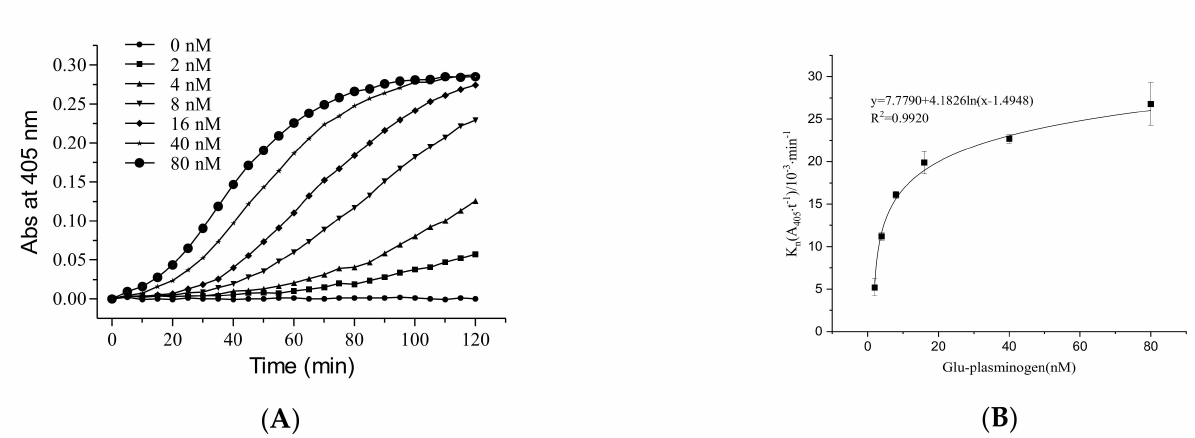
Figure 2. The role of Glu-plasminogen in the fibrinolytic activity of FGFC1. Plot of A 405 versus time ( A ) and the values of K n ( B ) at different Glu-plasminogen concentrations (0–80 nM). The reaction was incubated at 37 ◦ C and measured every five minutes for 120 min. The results are expressed as the mean ± SD, performed in triplicate. The concentration of pro-uPA and FGFC1 in the reaction system were 9 nM and 0.018 mM,